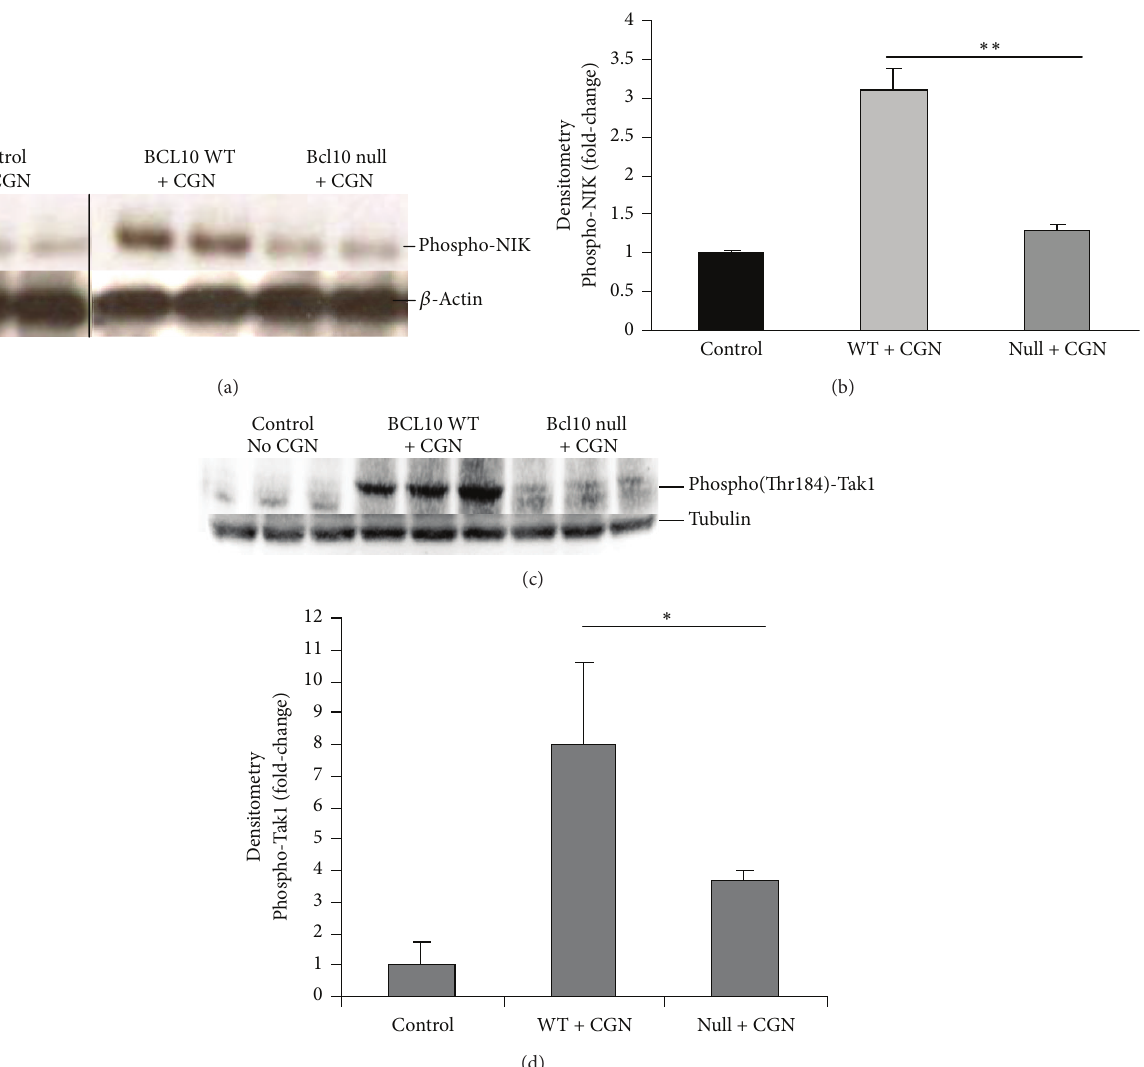
Figure 6: Different responses of phospho(Thr559)-NIK and of phospho(Thr184)-Tak1 following carrageenan in Bcl10 null mice. (a) The immunoblot shows that phospho-NIK does not increase following exposure to carrageenan in the Bcl10 null mice, in contrast to the finding in the wild type mice. (b) Densitometry confirms the increase in phospho-NIK in the Bcl10 WT mice treated with carrageenan compared to the Bcl10 null mice ( 𝑃 = 0.01 , unpaired t -test, two-tailed). (c) In contrast, phospho-Tak1(Thr184) was somewhat increased in the Bcl10 null mice’s intestinal tissue, although less than in the wild type mouse tissue. (d) Densitometry confirms the visual impression that the phospho- Tak1 is significantly reduced in the Bcl10 null versus Bcl10 WT mouse following CGN exposure ( 𝑃 < 0.05 , unpaired t -test, two-tailed). CGN: carrageenan; WT: wild type; NIK: NF- 𝜅 B inducing kinase; Tak: TGF- 𝛽 activated